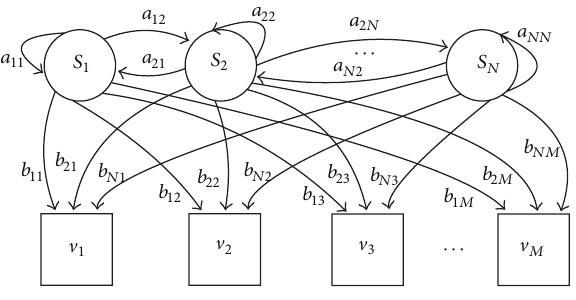
Figure 3: Hidden Markov